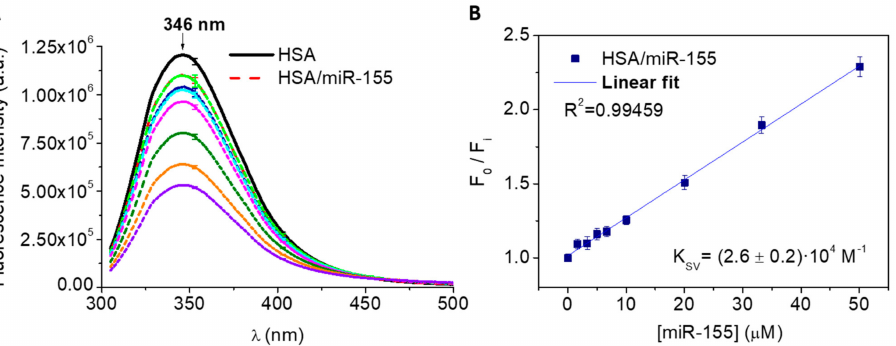
Figure 2. ( A ) Fluorescence quenching of 5 µ M HSA in Tris-HCl buffer, pH 7.0, upon titration with miR-155 (1.5–50 µ M); emission spectra have been collected using λ exp = 295 nm, at 298 K. ( B ) linear fitting of the fluorescence intensity as a function of miR-155 concentration according to Equation (2); the extracted K SV value being reported. The arrow indicates the peak of the spectra, while the bars indicate the errors.